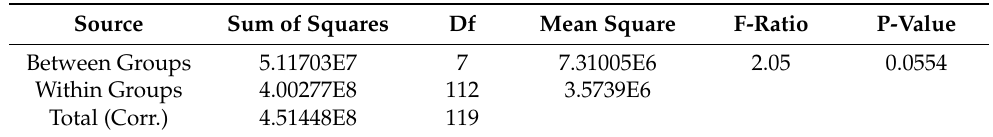
Table 5. ANOVA table for Col_3 Weight loss by Col_1 heat